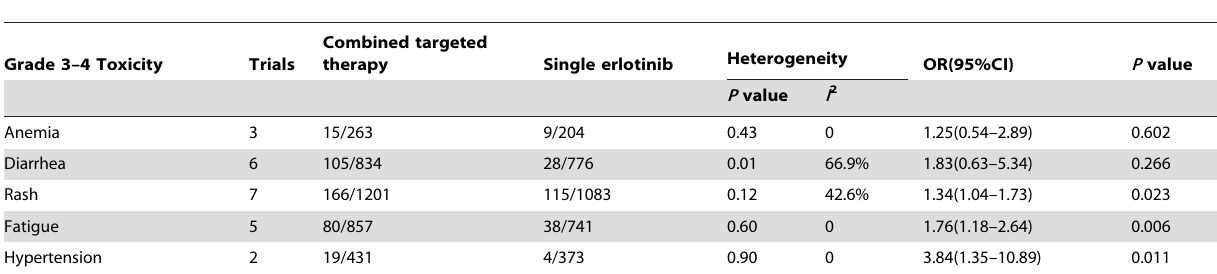
Table 4. Comparison of grade 3 or 4 toxicities between combined targeted therapy and erlotinib